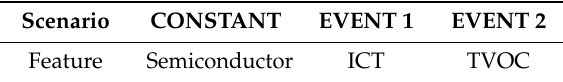
Table 1. Presentative feature on the scenarios. Data from the CONSTANT situation is showing a typical semiconductor sensor data feature, while in EVENT 1 and EVENT 2, the ICT sensor and TVOC gas characteristics are relatively displayed.